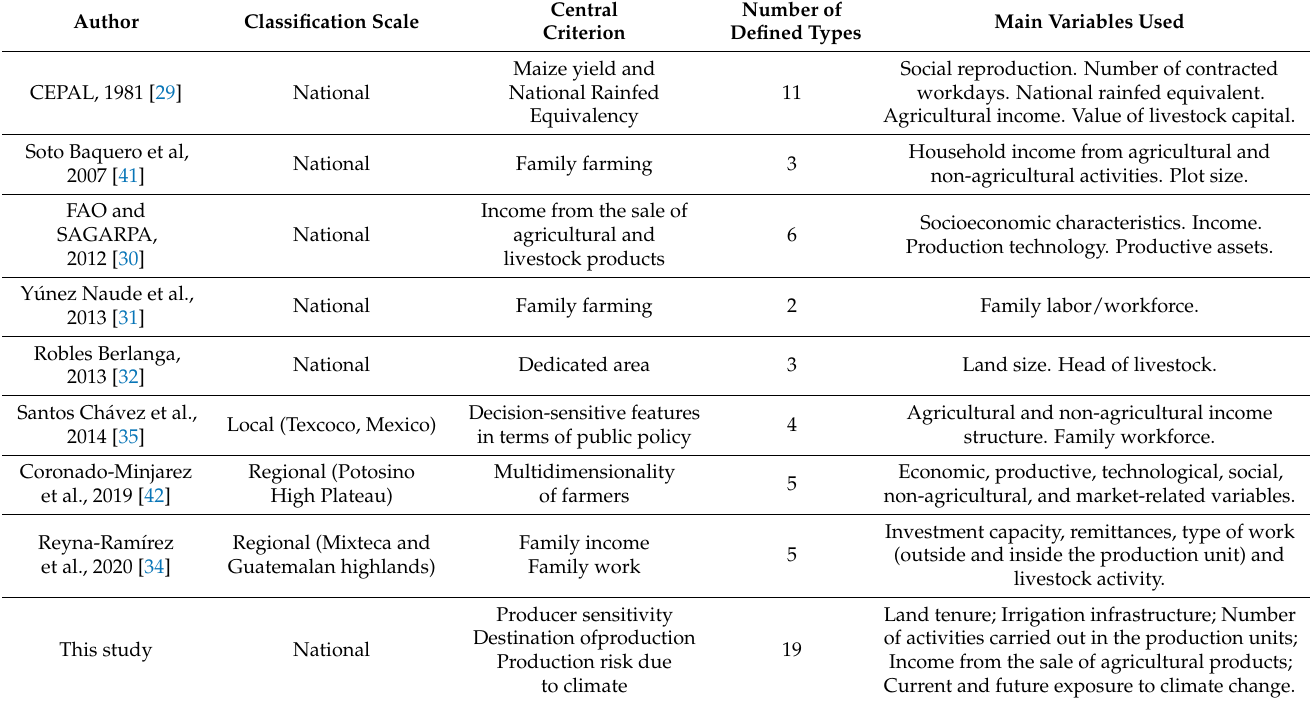
Table 1. Typology proposals for Mexican farmers and their main